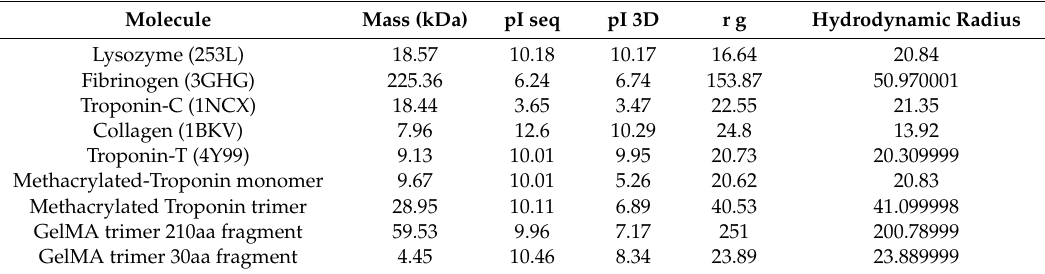
Table 1. Calculated chemical descriptors.